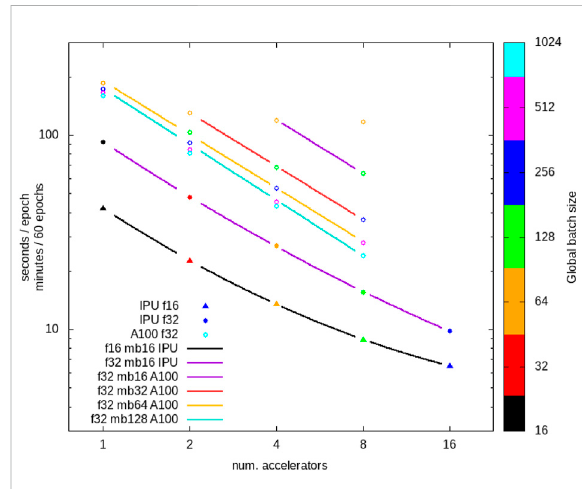
FIGURE 5 Training time per epoch (900 k images in set) versus number of accelerators for various global batch sizes. We indicate FP16/ FP32 for the IPU case and note that all A100 results are based on the FP32 tests. The trend curves follow the coef fi cients given in Table